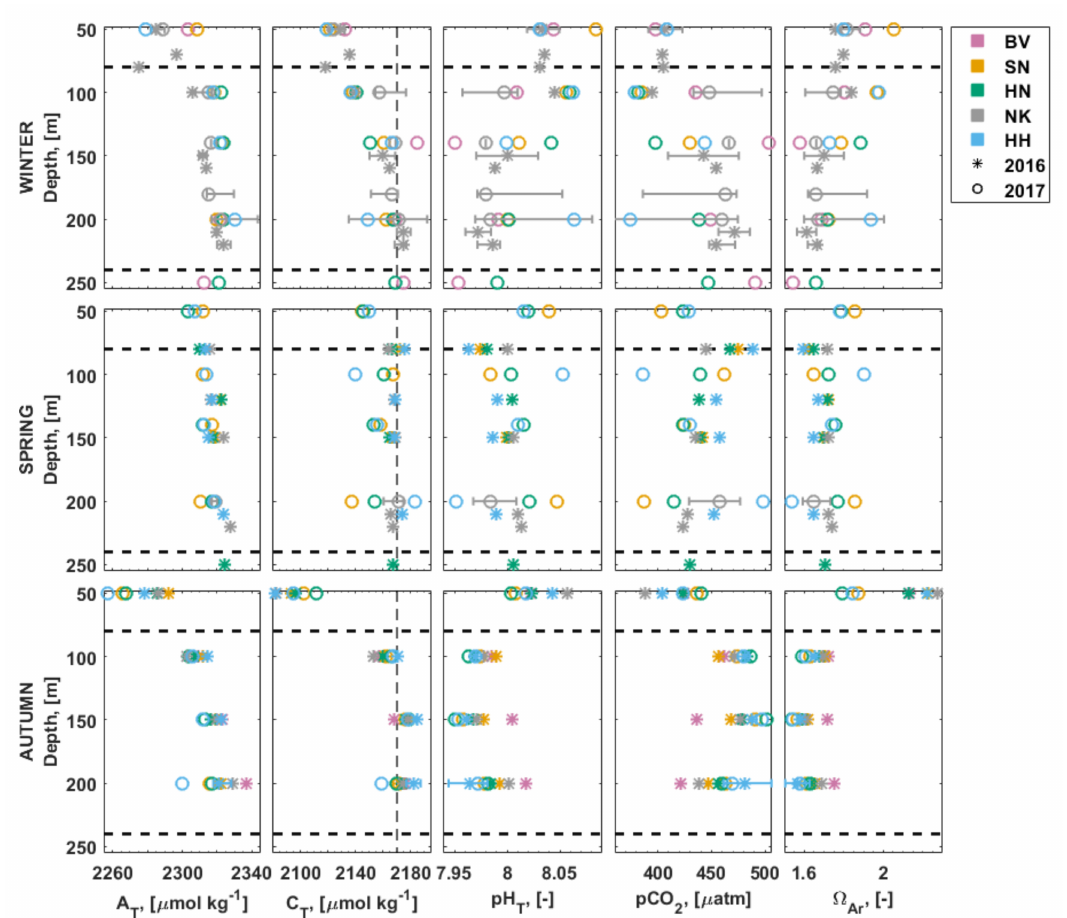
Figure 5. Depth profiles (y-axes) of carbonate chemistry at depths 50–250 m of the Langenuen Fjord: (first row) winter (February 2016 and January 2017), (second row) spring (April 2017 and May 2016), and (third row) autumn (August 2017 and October 2016), for (first column) total alkalinity, A T , (second column) total inorganic carbon, C T , with 2070 µ mol kg − 1 marked, (third column) pH T , (fourth column) partial CO 2 pressure, pCO 2 , and (fifth column) aragonite saturation, Ω Ar . The errorbars show the range of the variable (min, max) for cruises with multiple CTD cast samples at one station, and the marker shows the median for the station (HH—blue, NK—gray, HN—green, SN—orange, BV—purple) over the cruises. The 2016 measured values are shown with asterisks (*) and 2017 with circles (o). The dashed line represents the definition for depths of the living CWCs (80–240